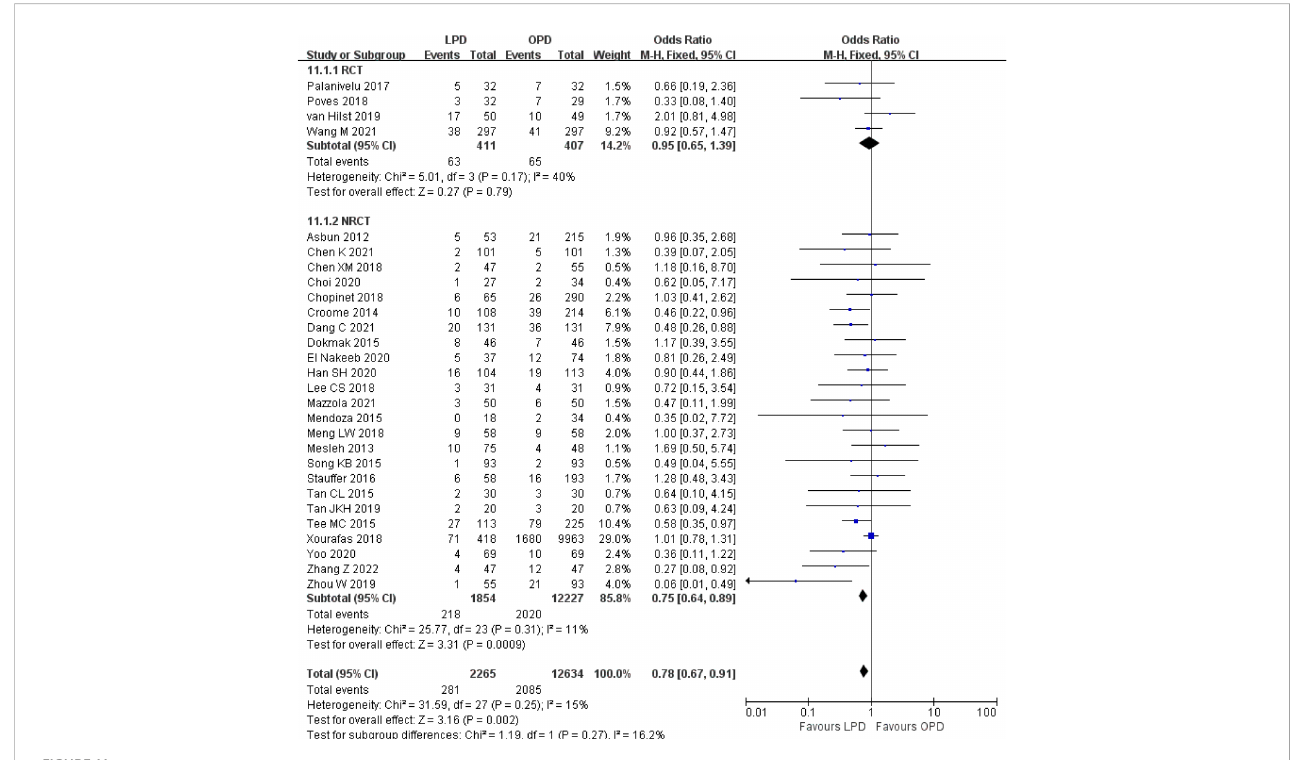
FIGURE 11 Forest plot of comparison between LPD and OPD on delayed gastric emptying. LPD, laparoscopic pancreaticoduodenectom; OPD, open